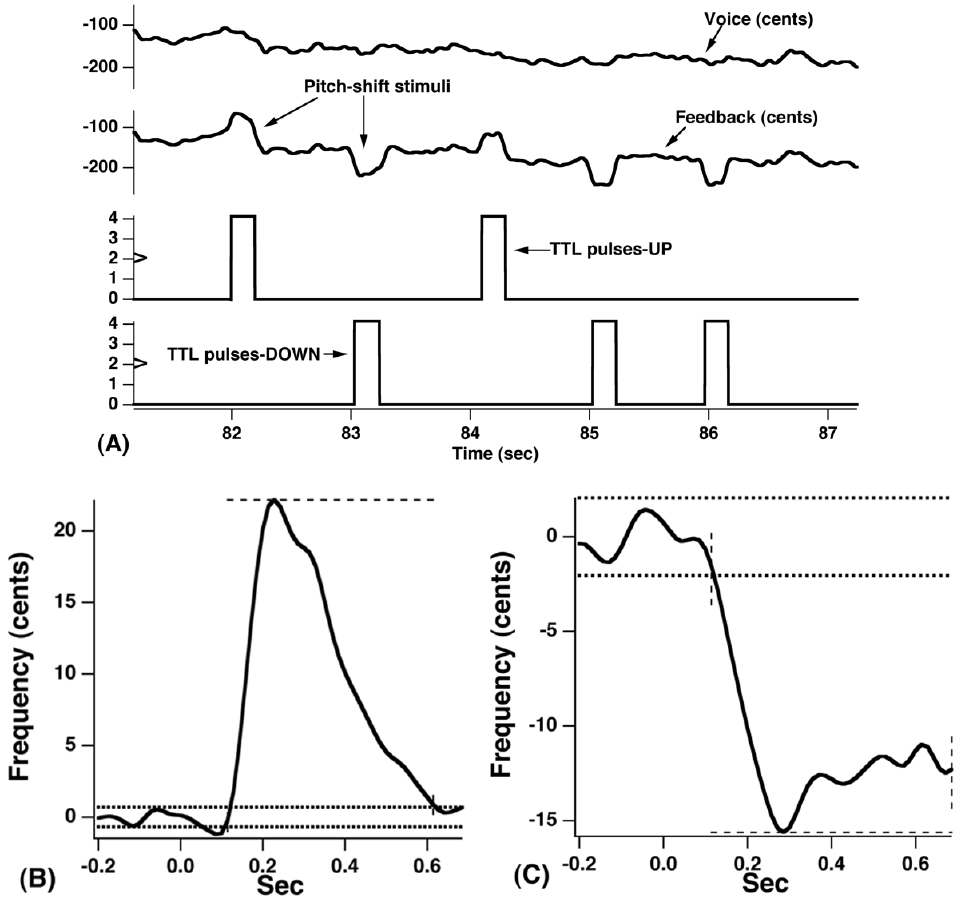
Figure 1. Contours of voice F 0 (top trace), auditory feedback (middle trace), and TTL pulses (bottom traces) (A) and two representative averaged vocal responses to 2 100 cents (B) and + 100 cents (C) pitch-shifted stimuli. For Figure 1A, the arrows in the contour of auditory feedback denote the upward and downward pitch-shifted stimuli (100 cents). For Figures 1B and 1C, horizontal dense dotted lines represent 6 2 standard deviations of the pre-stimulus mean averaged F 0 . Vertical dashed lines indicate the onset and offset times of the responses. Horizontal sparse dashed lines indicate the response magnitude as reflected by the maximal or the minimal value of the average response. Time 0 represents the onset of pitch-shift perturbation.